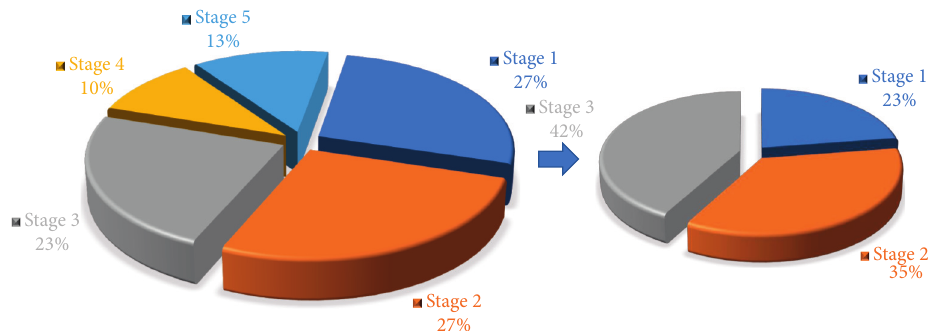
Figure 4: Intelligent analysis model weight